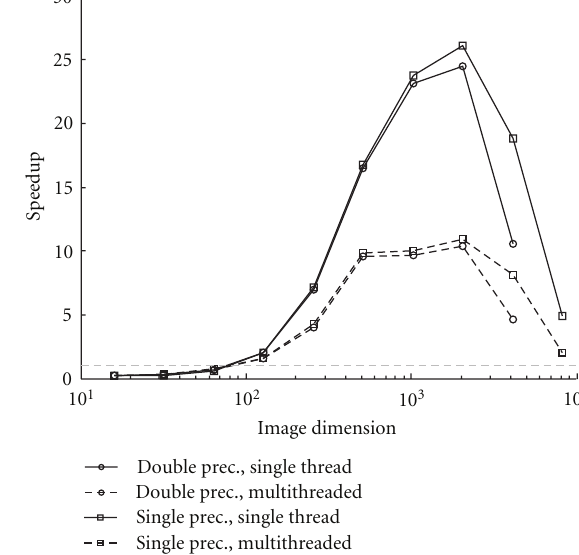
Figure 2: Speedup factors for the CS MRI reconstruction as a function of image size with and without CPU multithreading. The gray, dashed horizontal line shows a speedup of one.